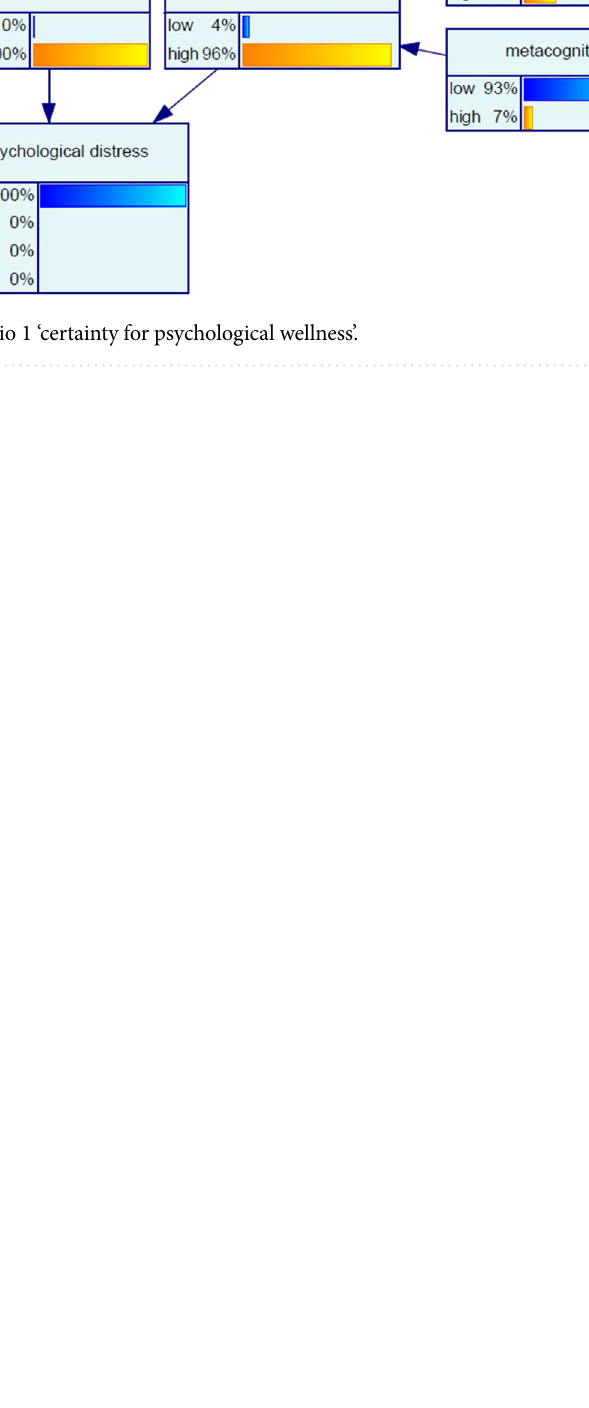
Table 3. Scenario 1 ‘certainty for psychological wellness’, displaying changes in Bayesian network node states to achieve certainty of a participant being psychologically well. * (cid:31) % =